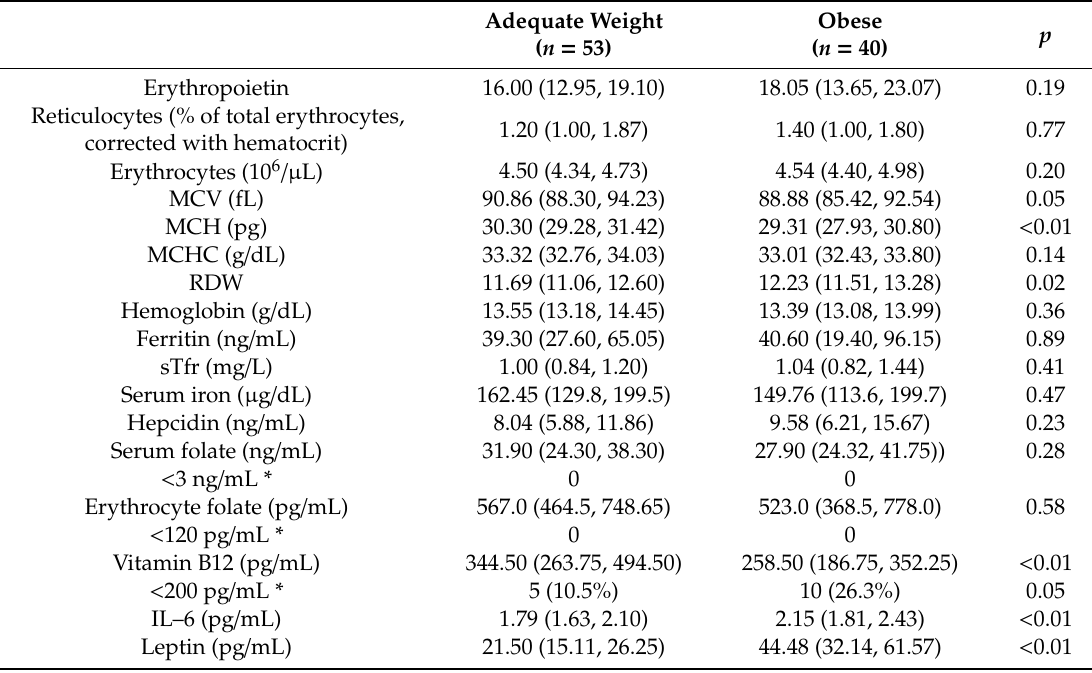
Adequate Weight Obese ( n = 53)